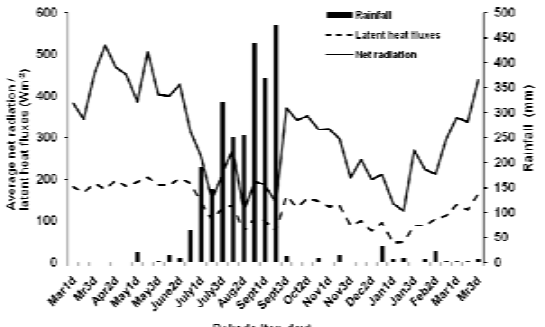
Figure 2. Seasonal behaviour of energy balance components